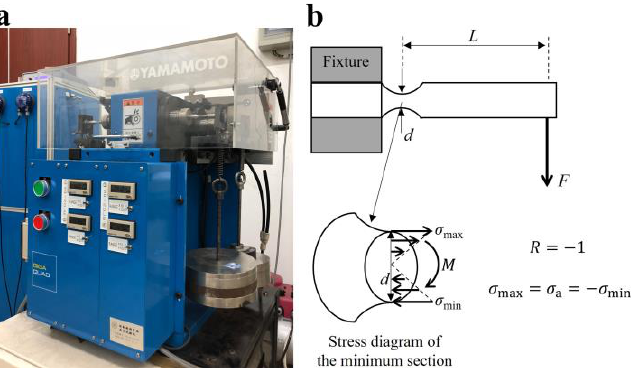
Figure 2. ( a ) GIGAQUAD YRB200 rotating bending fatigue machine. ( b ) A stress diagram of the minimum section of the specimen under bending load.